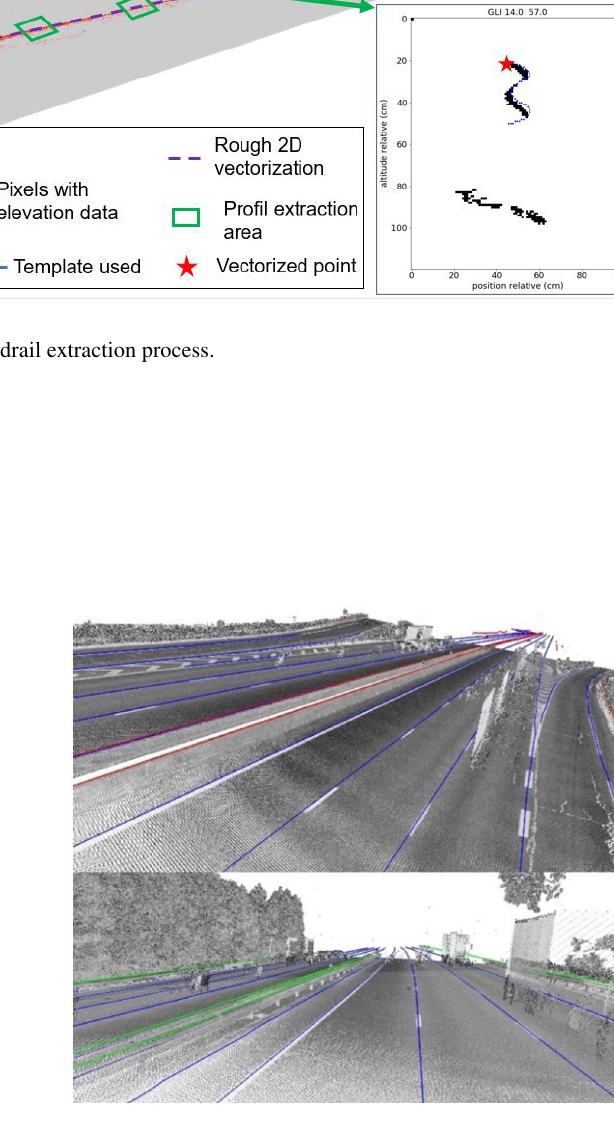
Figure 11. Results of the road marking vectorization in blue and guardrail in green or